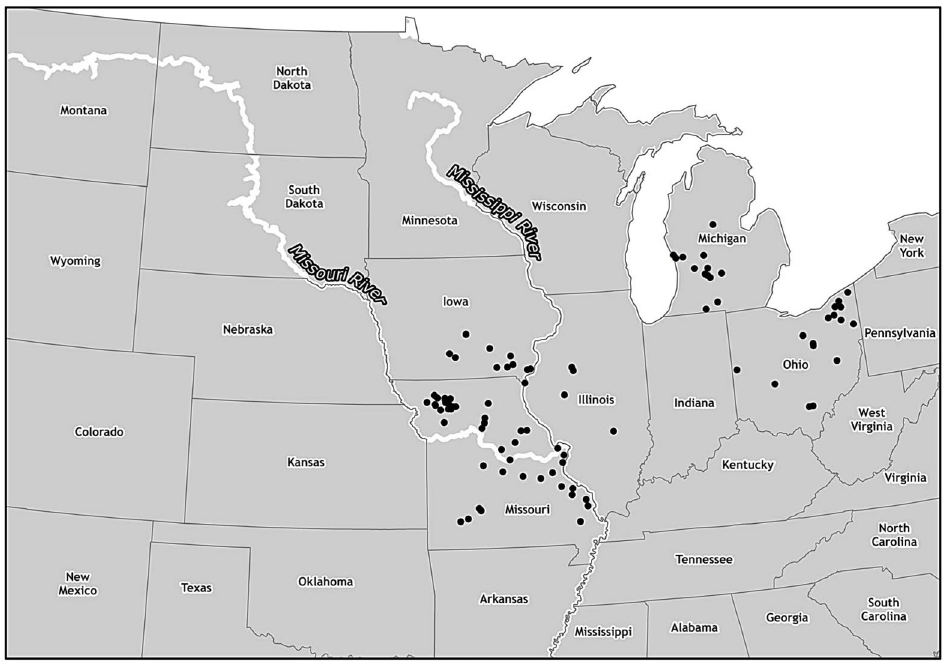
Fig 3. Density of captive white-tailed deer EHD cases during 2012 outbreak. To protect the confidentiality of individual producers, each symbol represents a captive white-tailed deer case of EHD randomly placed in the county in which it